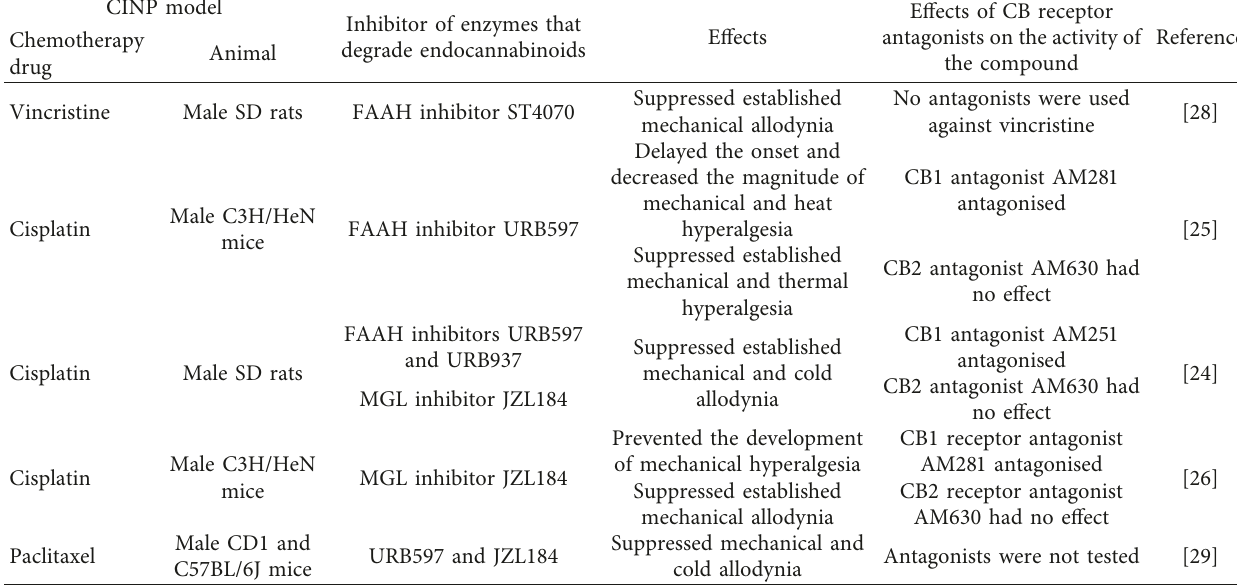
Table 2: Effects of inhibitors of enzymes that degrade endocannabinoids in animal models of